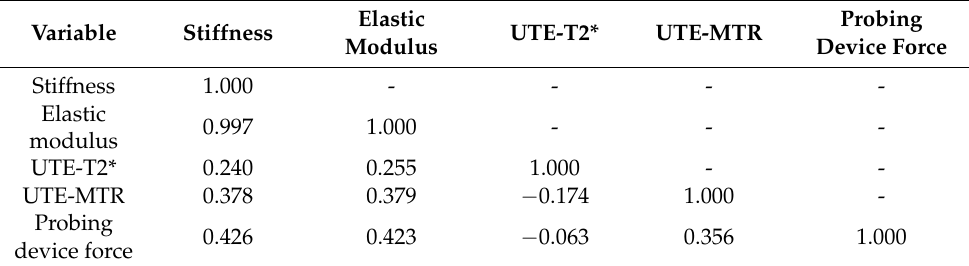
Table 2. Pearson correlation coefficients among variables.